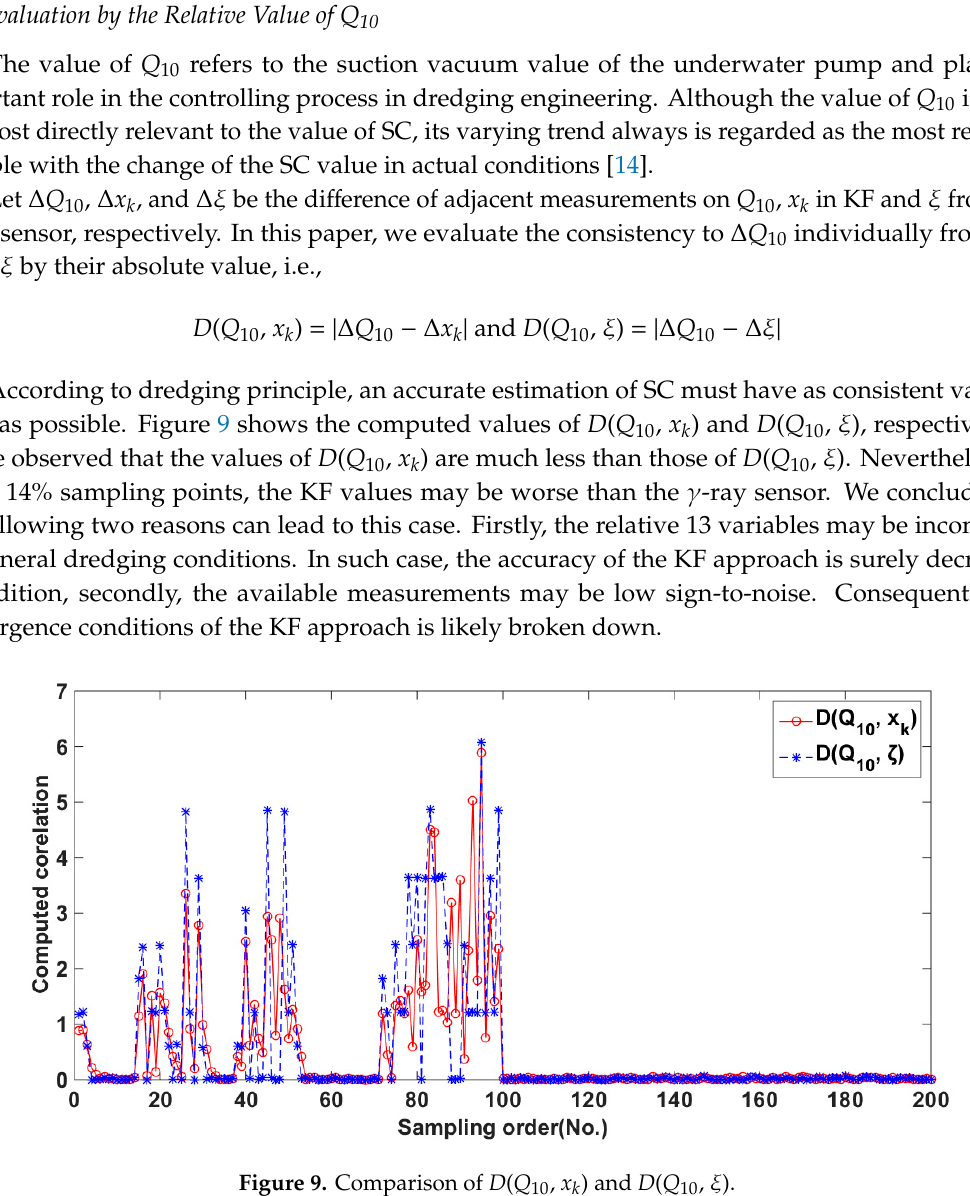
Figure 9 Figure 9. Comparison of D ( Q 10 , x k ) and D ( Q 10 ,